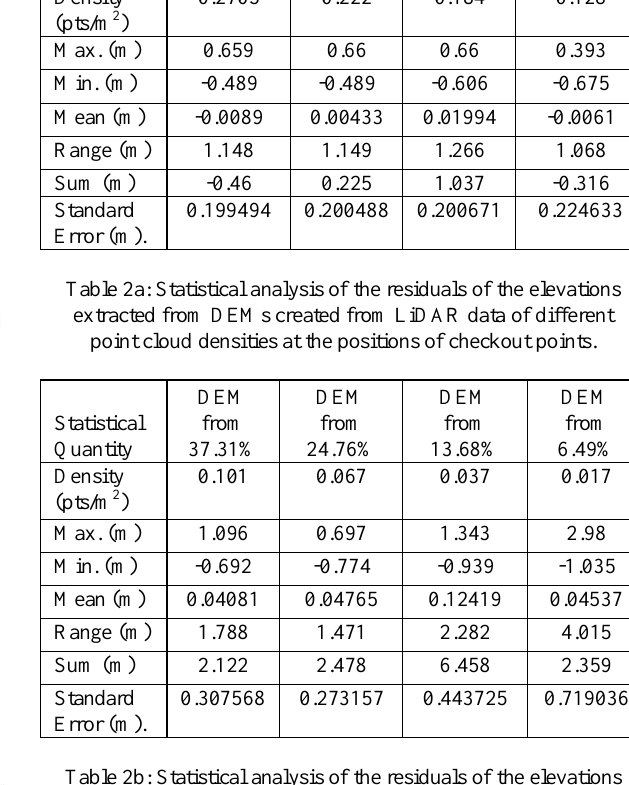
Table 2b: Statistical analysis of the residuals of the elevations extracted from DEMs created from LiDAR data of different point cloud densities at the positions of checkout